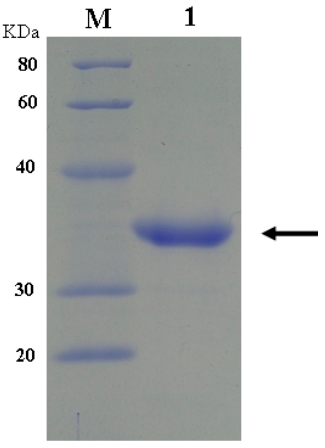
Figure 2. Homogeneity of purified wPU by SDS-PAGE analysis. Lane 1: purified wPU; lane M: molecular weight markers.